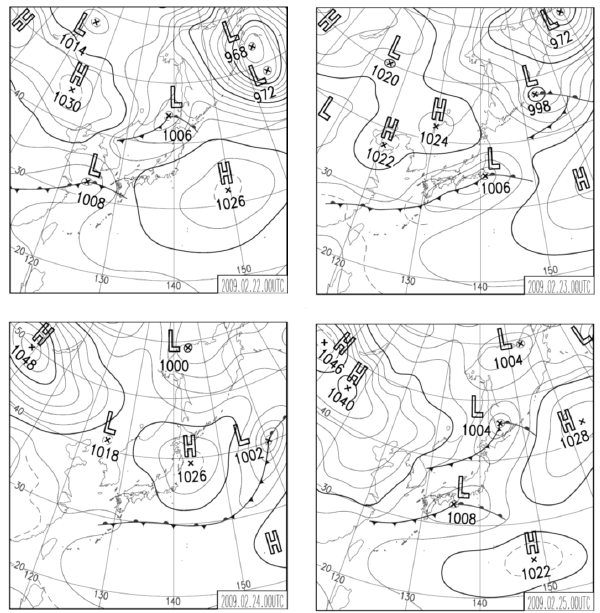
Fig. 5. Weather charts of the surface level from 22 February 2009 to 25 February 2009, provided by the Japan Meteorological Agency. reached almost 1 m at 10:25 JST, corresponding to the maxi- mum high-water level, as listed in Table